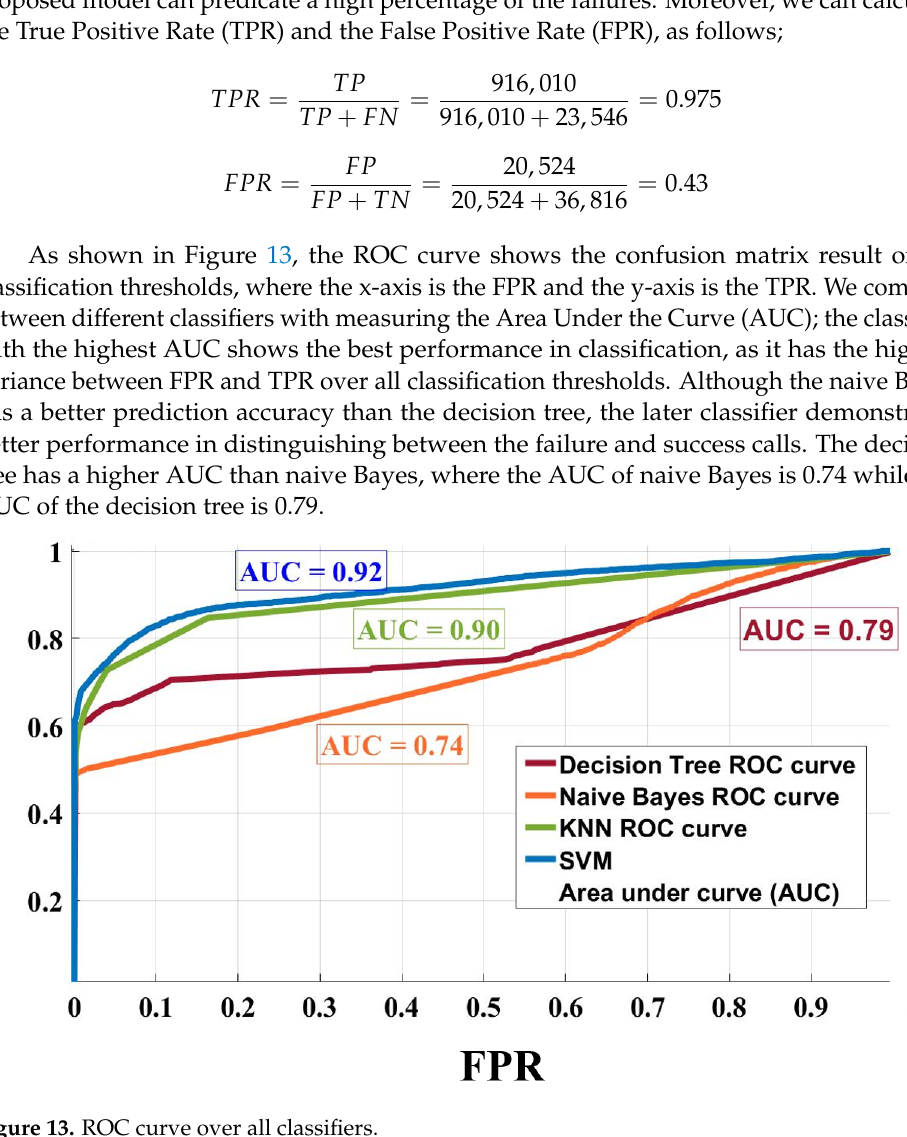
Figure 13. ROC curve over all